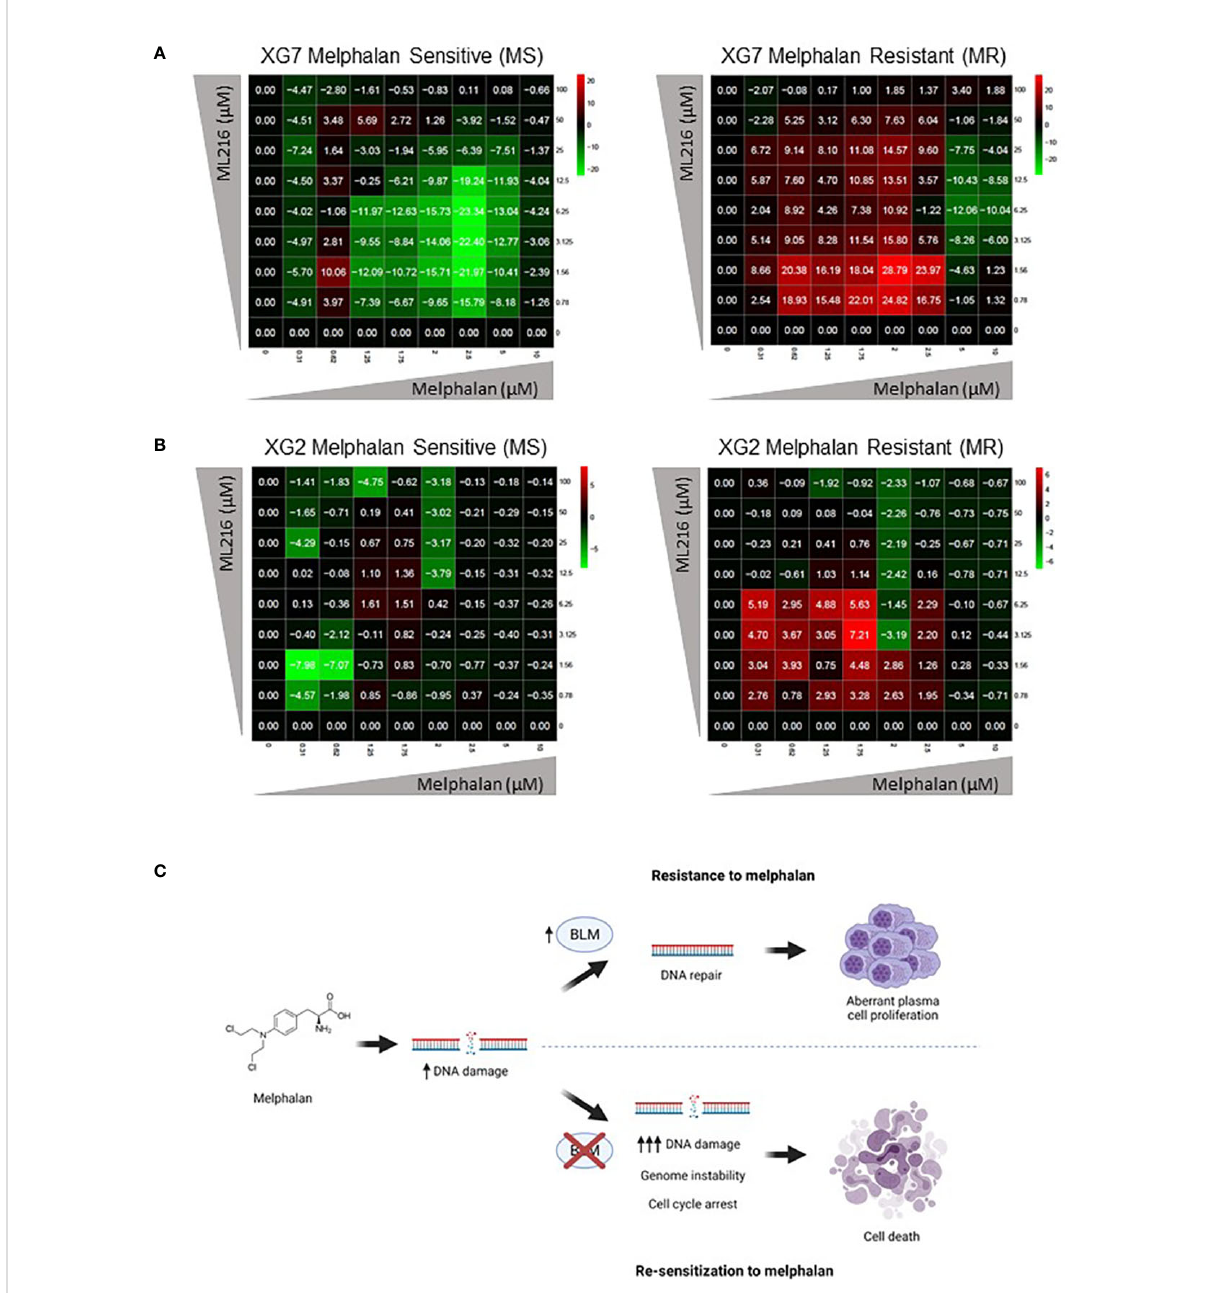
FIGURE 9 ML216 re-sensitizes Melphalan-resistant MM cells to Melphalan. Dose-response matrixes to measure synergy of ML216 and Melphalan co- treatment. Synergy scores are shown using a continuous pseudo-color scale ranging from dark-green (=antagonism) to dark-red (=synergism). (A) XG7 parental cells and XG7 MR (Melphalan Resistant) (Melphalan IC50: 0.625 m M and 7.5 m M respectively) were treated for 4 days with the indicated doses of ML216 and melphalan. Cell viability was assessed using CellTiter-Glo Luminiscent Cell Viability Assay and was normalized with respect to untreated conditions. Matrixes show the mean of 3-4 independent experiments. (B) Same as in (A) but comparing XG2 parental and XG2 MR (Melphalan Resistant) (Melphalan IC50: 0.625 m M and 2 m M respectively). Matrixes show the mean of 3 independent experiments. (C) Treatment of MM cells with melphalan produces DNA damage. Cells that overexpress BLM can cope better with the drug-induced DNA damage and therefore survive to the treatment, showing a resistant phenotype. On the contrary, BLM inhibition in combination with melphalan increases DNA damage to levels that tumoral plasma cells cannot ef fi ciently repair, leading to cell cycle arrest and eventually to cell death, overcoming melphalan-resistance. Figure was created with